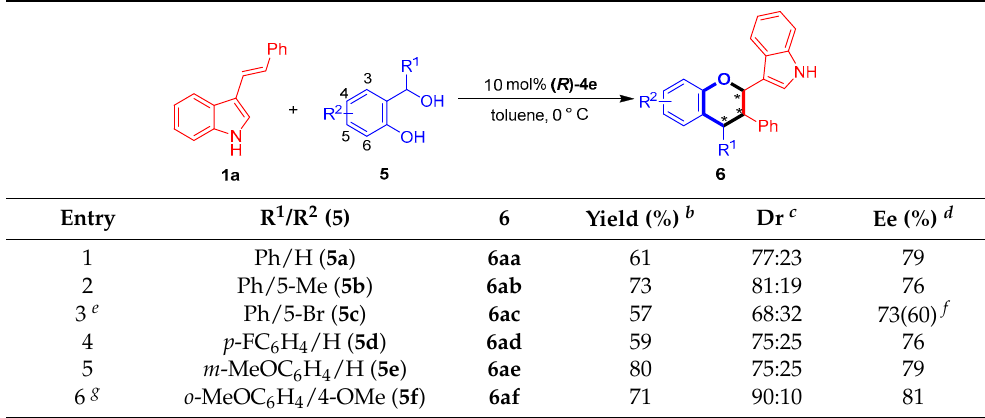
Table 7. Substrate scope of o -hydroxybenzyl alcohols 5 for [2 + 4] cycloaddition a .